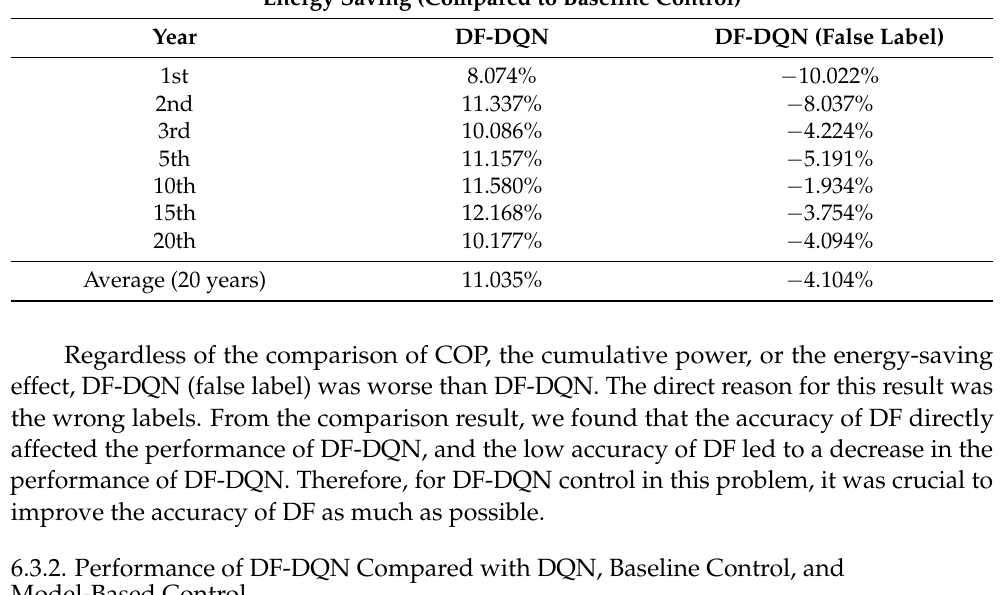
Table 2. Partial energy-saving effect comparison result.